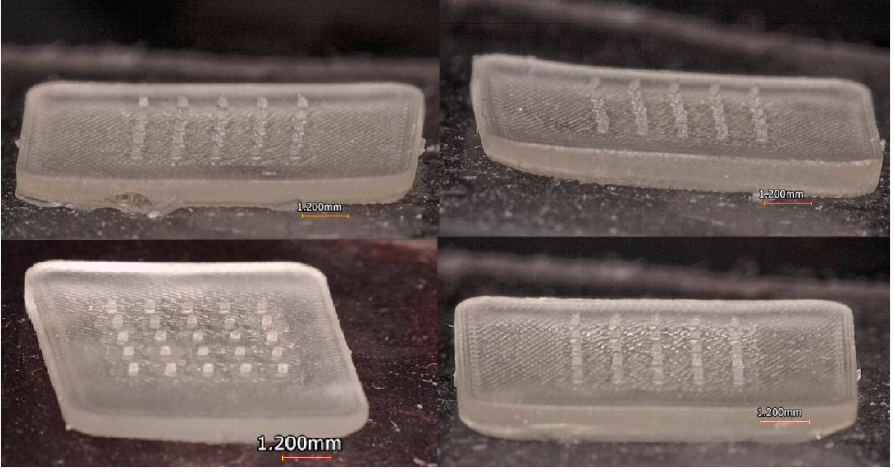
Figure 9. Manufacture of MN patches.